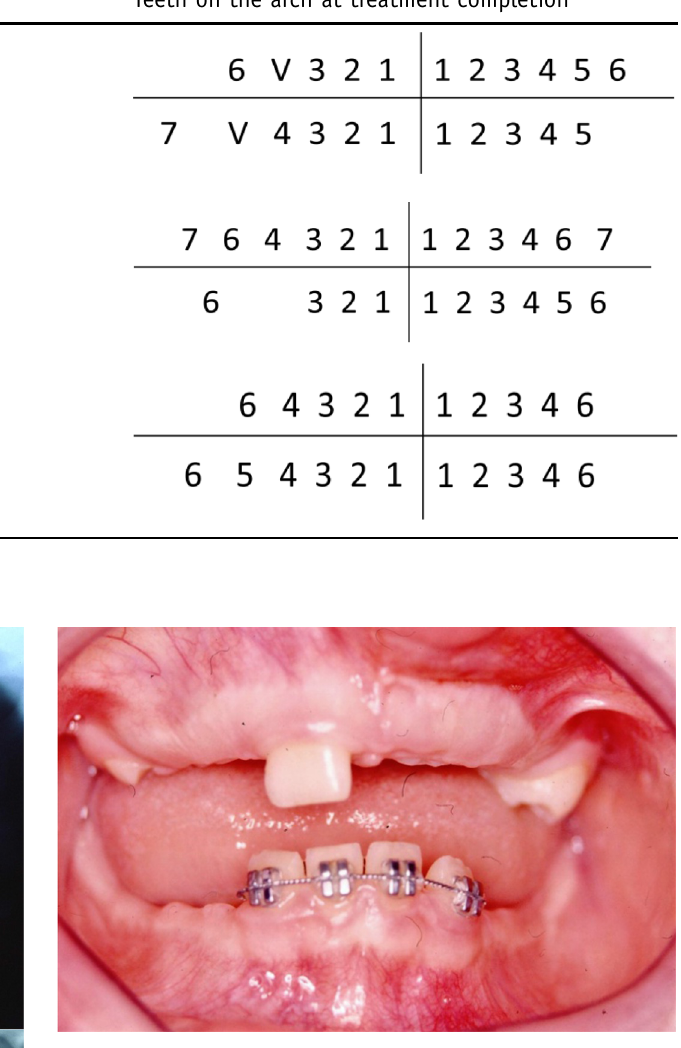
Fig. 5. Clinical view of patient C at the beginning of his treatment (age: 15